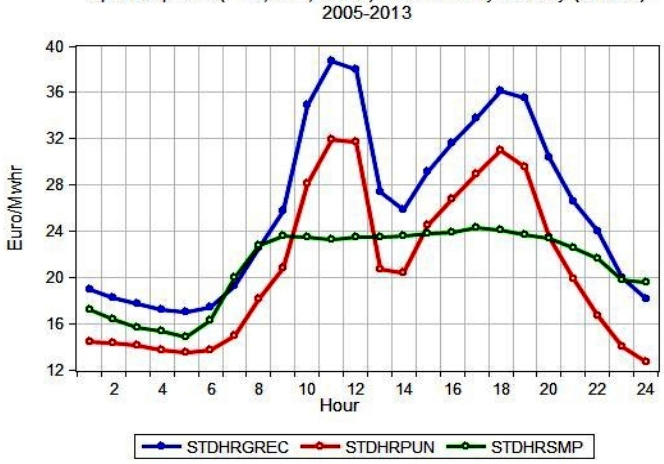
Figure 5. Mean hourly Volatility of Spot DA prices PUN, GREC and SMP,